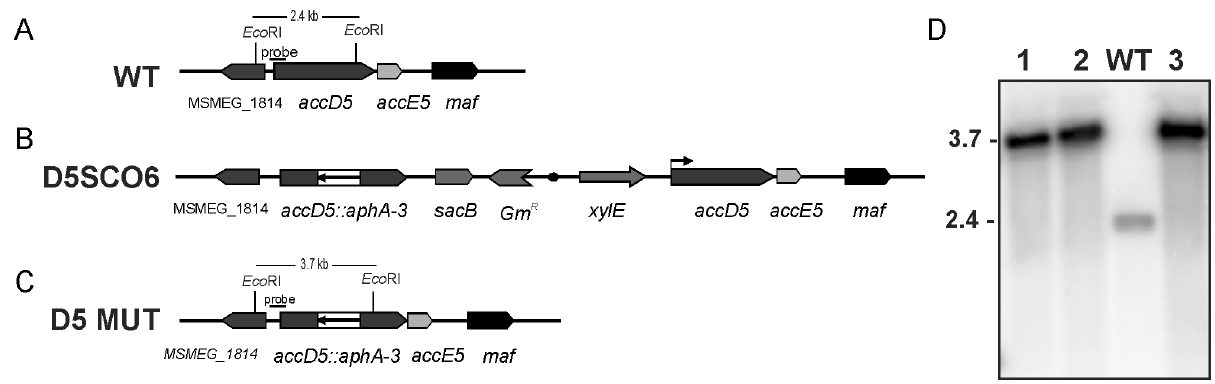
Figure 1. Allelic exchange of the accD5 locus of M. smegmatis . A-C. Genetic organization and partial restriction maps of the accD5 chromosomal region of (A) the wild-type strain mc 2 155, (B) the single crossover strain D5SCO6, and (C) the M. smegmatis D5DCO conditional mutant. D) Southern blot analysis of M. smegmatis accD5 mutants. Three conditional mutants were picked at random (lanes 1–3), and their chromosomal DNA digested with Eco RI and probed for hybridization with a 390 bp labeled fragment corresponding to the 5 9 region of accD5 . M. smegmatis mc 2 155 DNA was included as a control (WT). Molecular masses are indicated in kilobases.